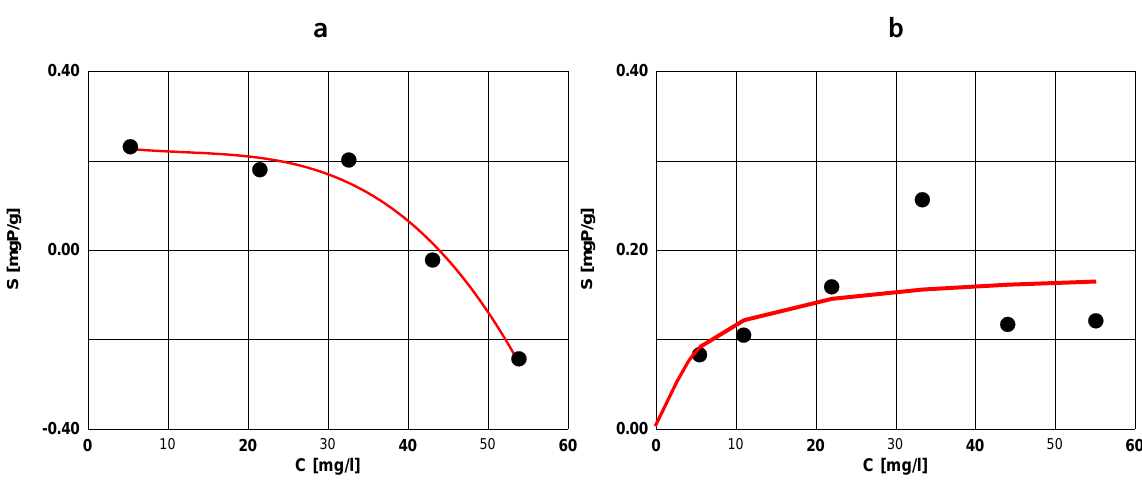
Figure 2. Phosphorus sorption capacity of substrate samples representing ( a ) high P content (549 mg kg –1 ) and ( b ) low P content (300 mg kg –1 ). Note different units on